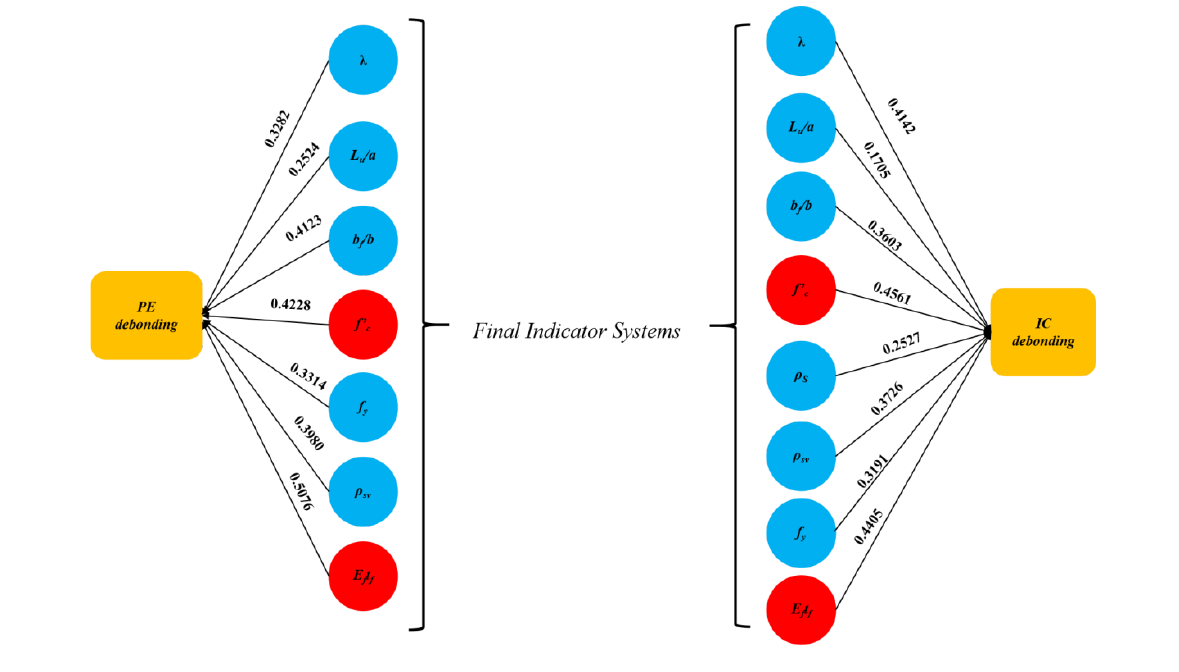
Figure 5. Indicator systems of the debonding failure.